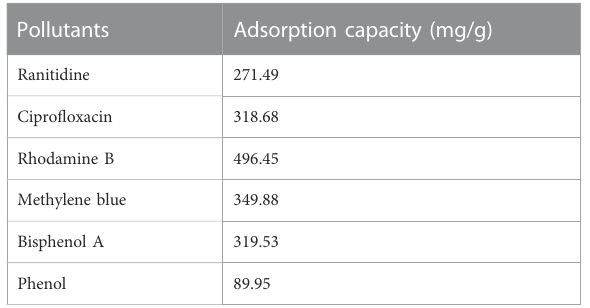
TABLE 4 Adsorption capacity of IKBCH on other